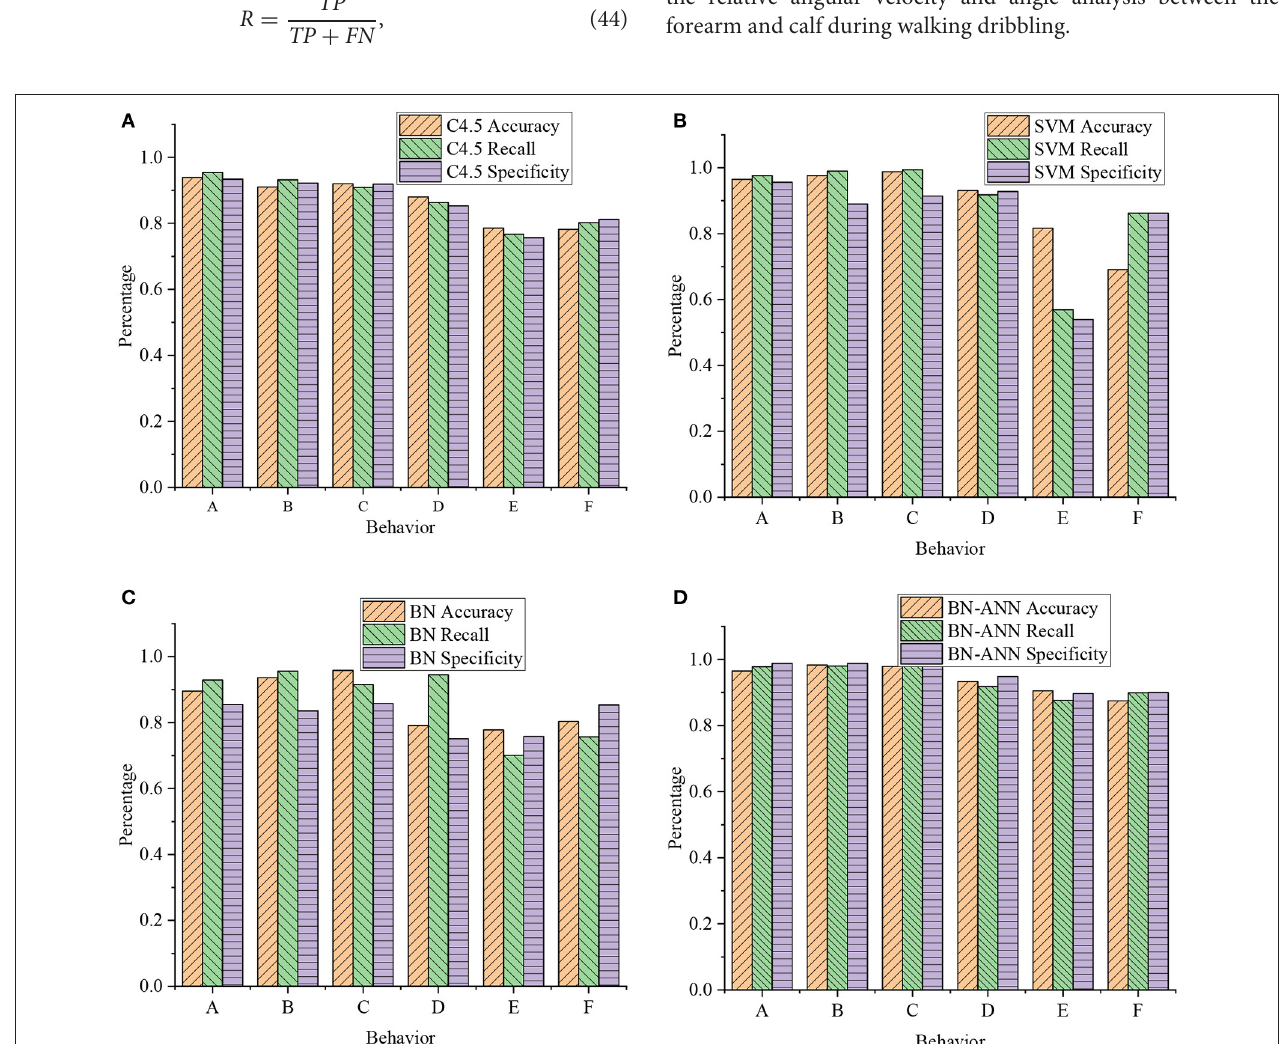
FIGURE 9 | Classification results of upper limb movements by different classification algorithms (A: catching; B: passing; C: shooting; D: dribbling on foot; E: dripping while standing; F: running dribbling). (A) accuracy and recall of C4.5; (B) accuracy and recall of SVM; (C) accuracy and recall of BN; and (D) accuracy and recall of back propagation–artificial neural network